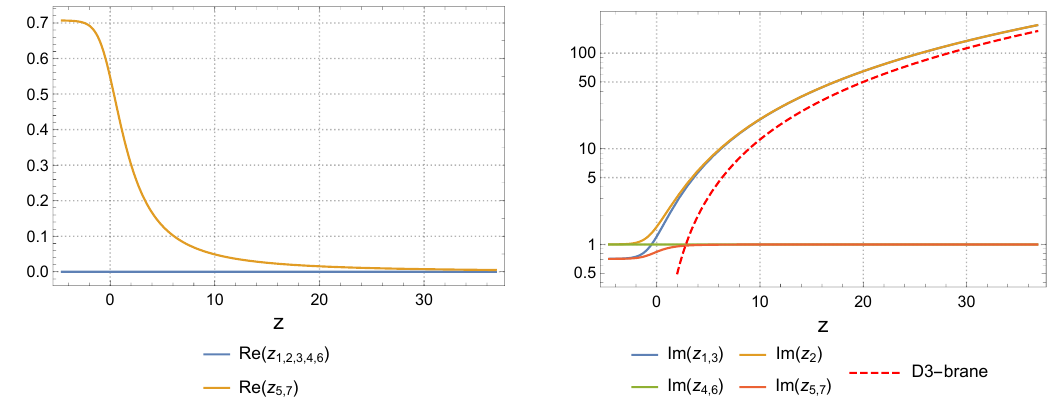
Figure 4 . Holographic RG flow from N = 4 SYM 4 (UV) to N = 2 & SU (2) J-fold CFT 3 (IR) with Λ = − 1 , Λ = 0 and ( λ ) = (0 , 0) 1 2 1 , λ 2